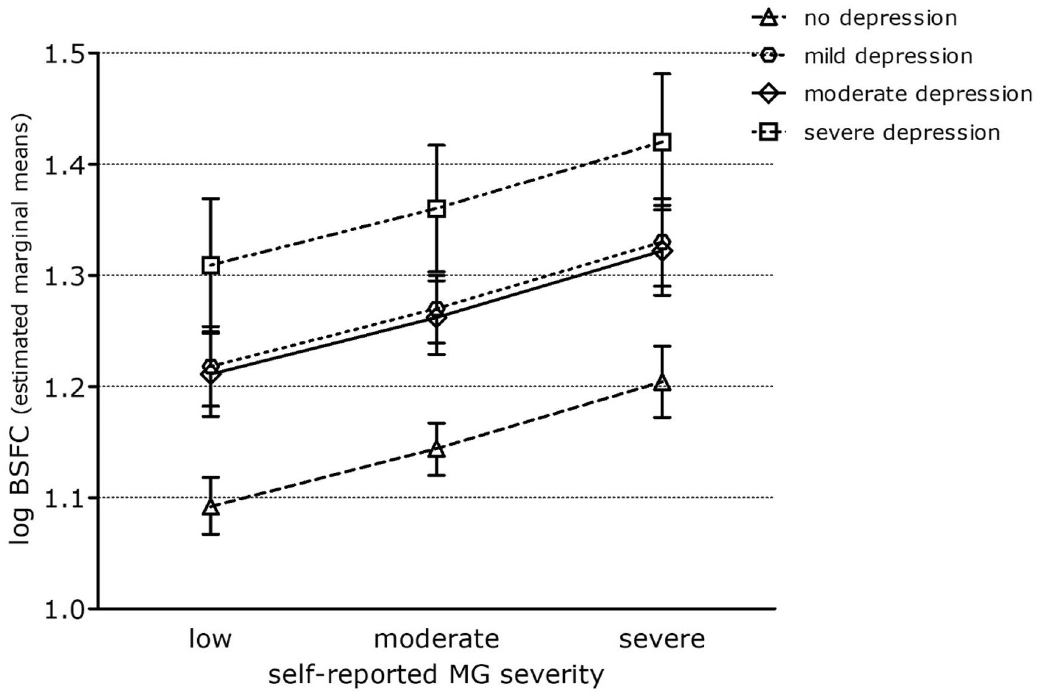
Figure 2. Adjusted logarithmized BSFC scale scores for different categories of depression according to HADS. Estimated marginal means with 95%CI for logarithmized BSFC scale scores after full adjustment for depression, gender, thymectomy, other autoimmune disease, cardiovascular disease, IVIG/Rituximab, myasthenic crisis/ exacerbation, duration, disease latency age, education, marital status. BSFC = burden scale for family caregivers; HADS = Hospital Anxiety and Depression